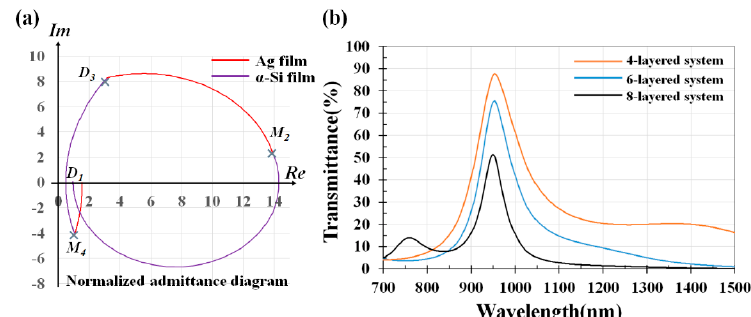
Figure 2. ( a ) NAD loci and ( b ) transmittance spectra of four-layered N i / D 1 M 2 D 3 M 4 / N sub = air/a-Si (67 nm)/Ag(15 nm)/a-Si(84 nm)/Ag(16 nm)/glass, six-layered N i / D 1 M 2 D 3 M 4 D 5 M 6 / N sub = air/a-Si(52 nm)/Ag(11 nm)/a-Si(40 nm)/Ag(13 nm)/a-Si(75 nm)/Ag(20 nm)/BK7 glass system,